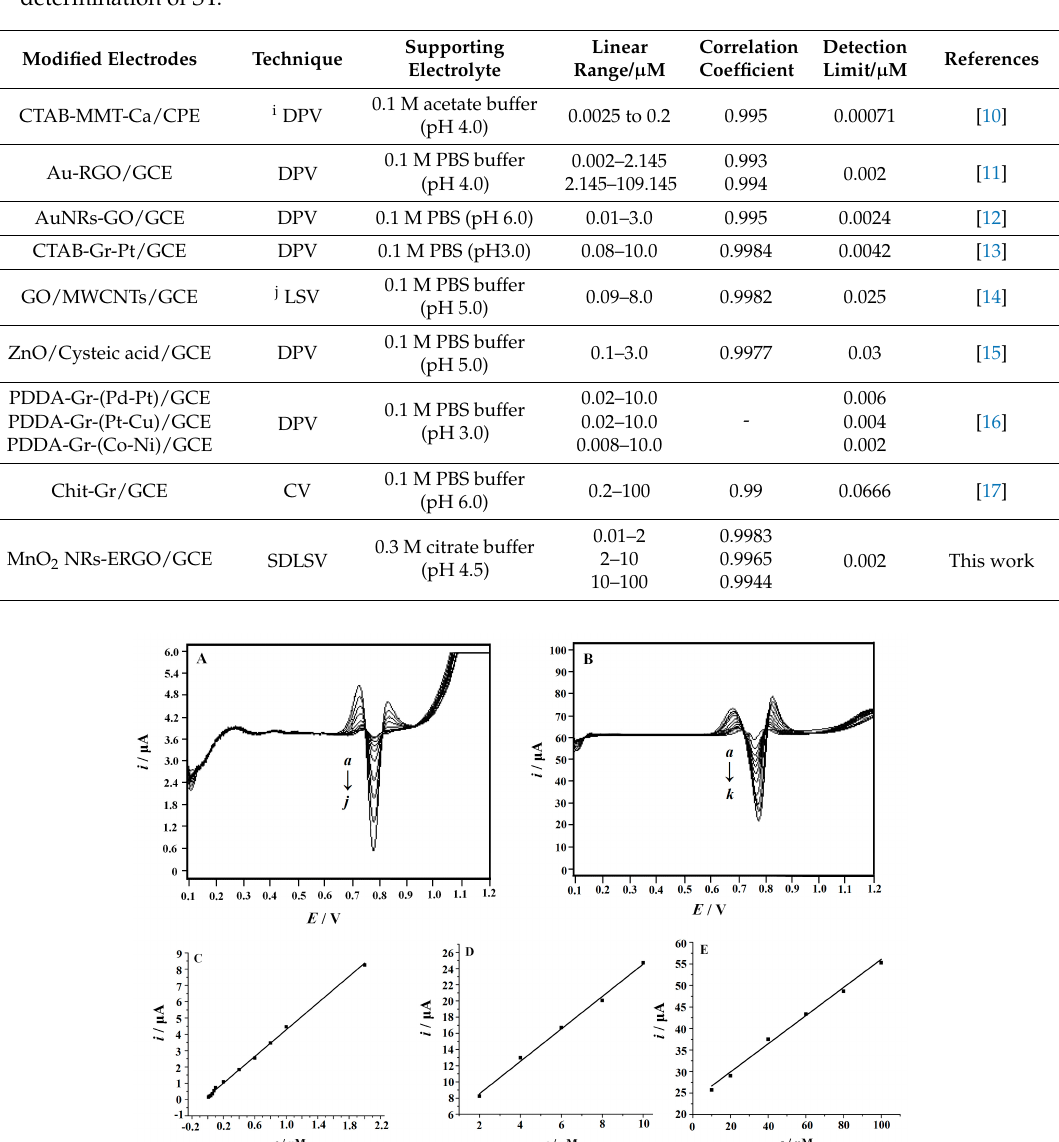
Figure 8. Second-order derivative linear scan voltammograms obtained at MnO 2 NRs-ERGO/GCE in 0.3 M citric acid-sodium citrate buffer (pH 4.5) containing different concentrations of SY. ( A ) From a to j: 0.01, 0.02, 0.04, 0.06, 0.08, 0.1, 0.2, 0.4, 0.6, 0.8 µ M; ( B ) From a to k: 1.0, 2.0, 4.0, 6.0, 8.0 10, 20, 40, 60, 80, 100 µ M; ( C – E ) the calibration plots of the concentration of SY versus peak current (C: 0.01~2.0 µ M; D:2.0~10 µ M; E: 10~100 µ M). Accumulation potential: 0.1 V, accumulation time: 180 s, scan rate 0.1 V/s.